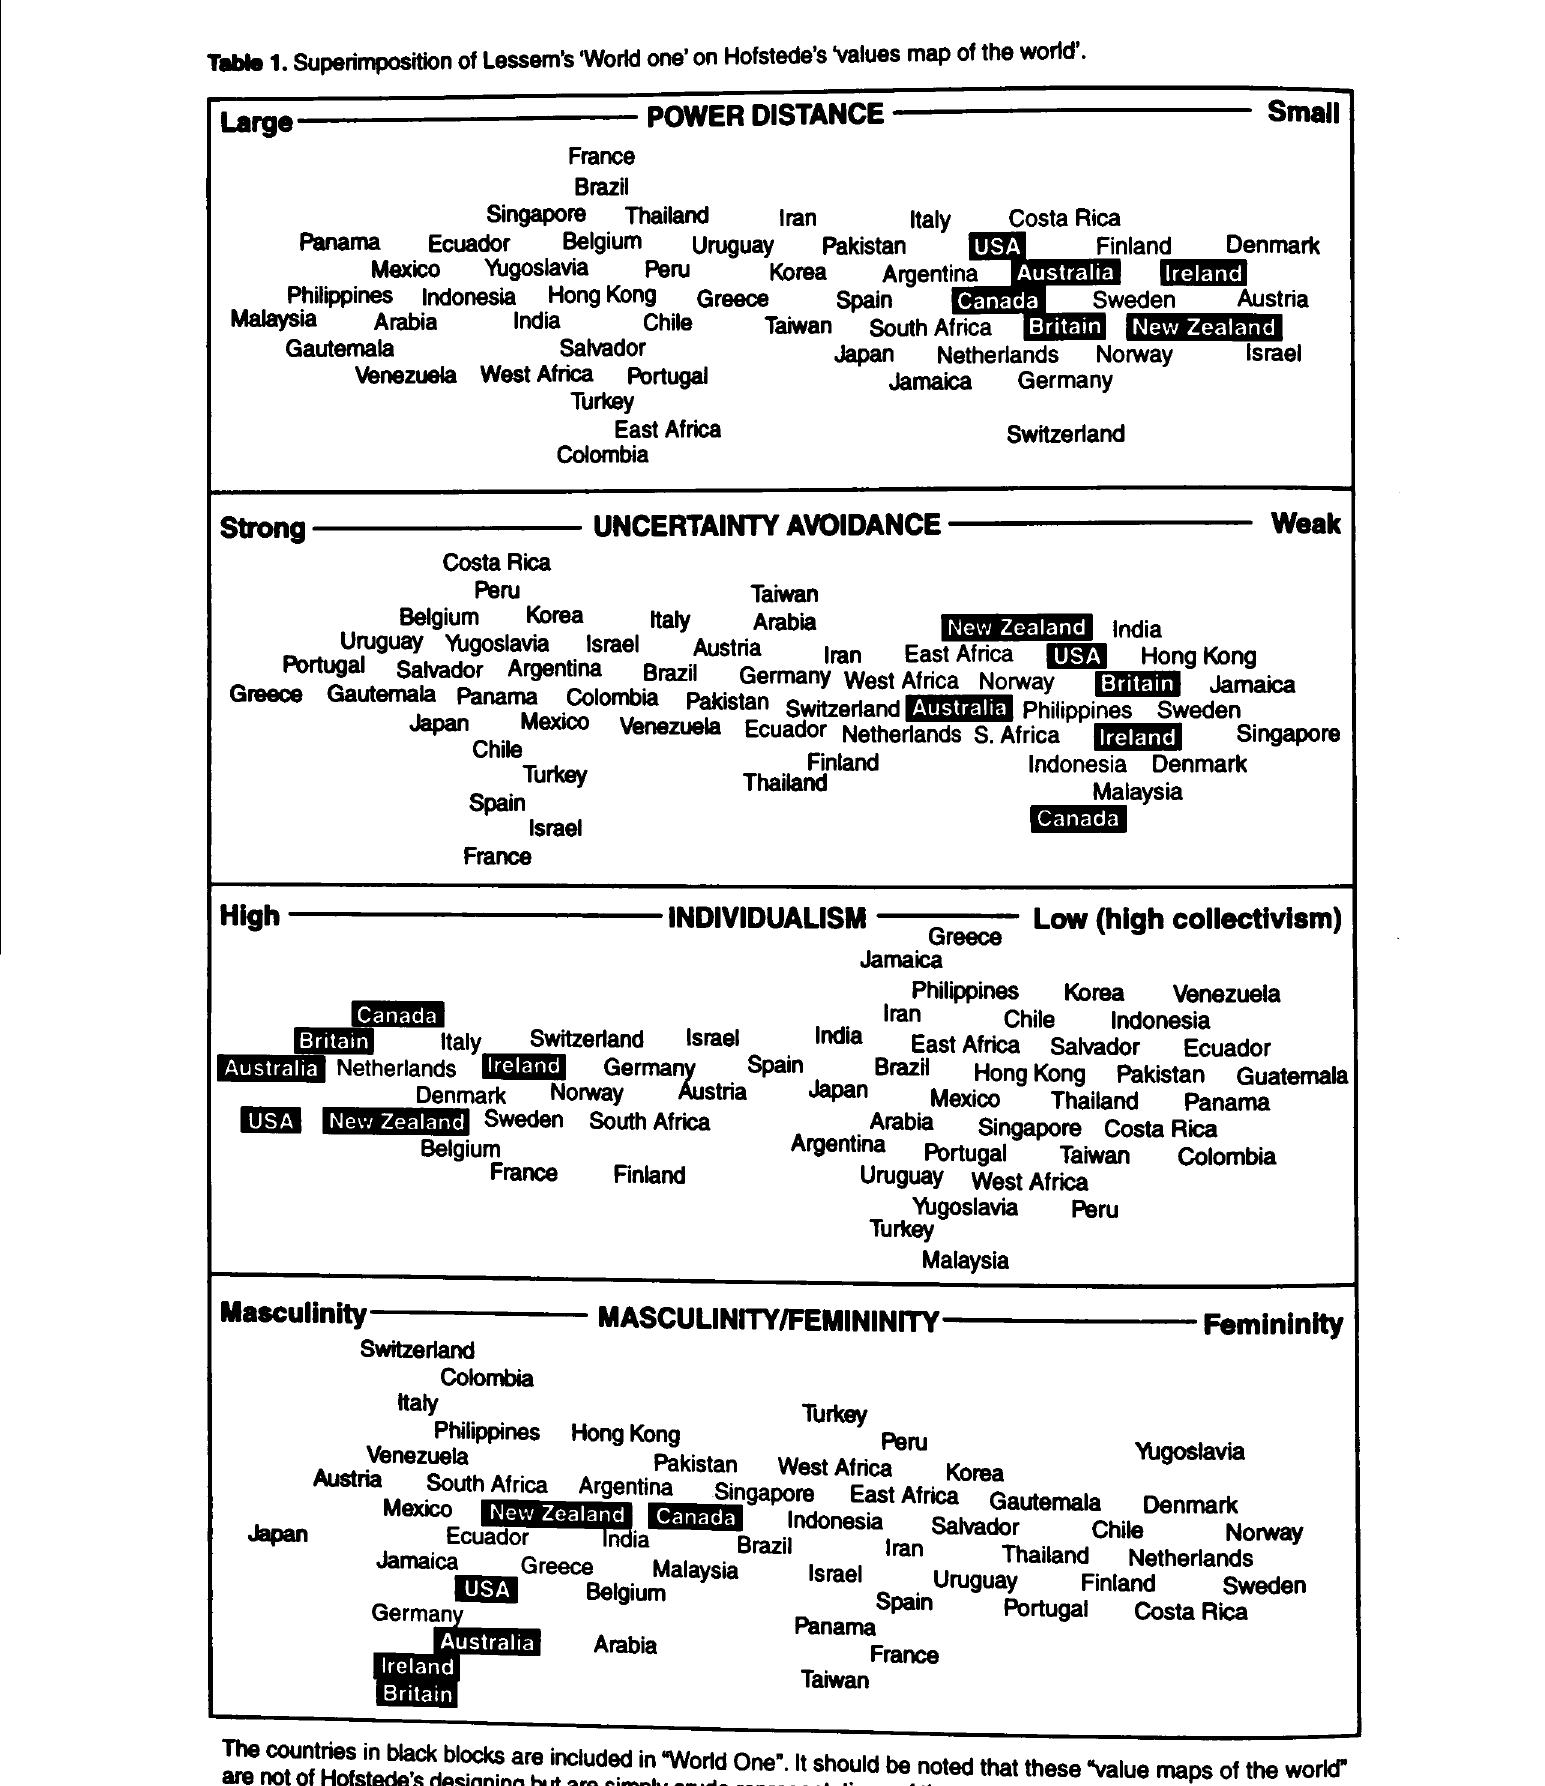
Table 1. Superimposition of Lessem's World one' on Hofstede's 'values map of the world'. Large-------- POWER